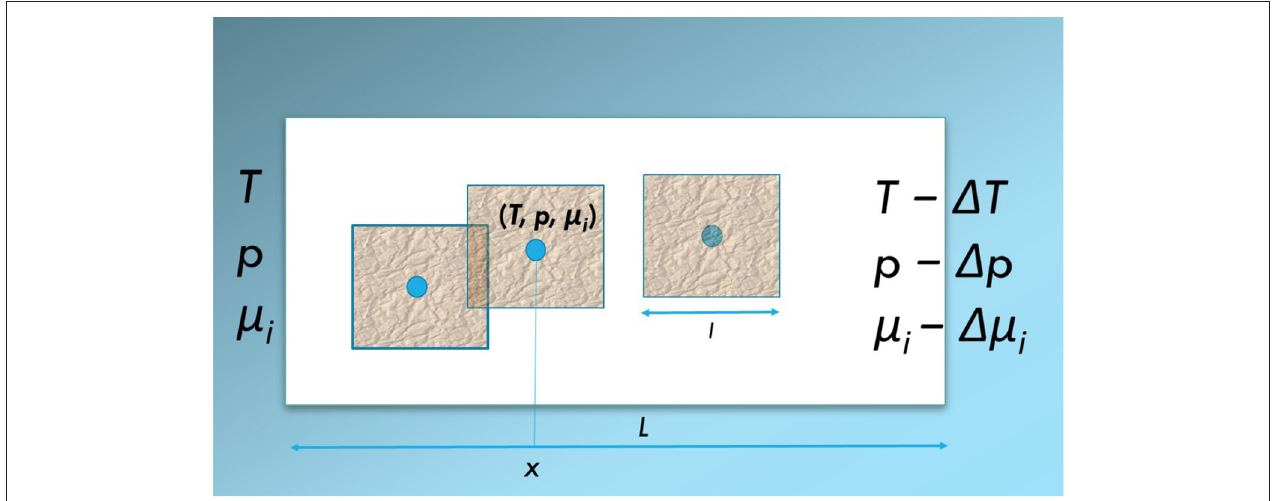
FIGURE 1 | Schematic illustration of a heterogeneous system (white box, length L ) exposed to a difference in temperature, 1 T , pressure, 1 p , or chemical potential 1µ i . The system is isolated in the y , z − directions. Net flows take place in the x − direction. Three representative elementary volumes, REVs (magenta squares, length l ) are indicated. The REVs may overlap. Each is represented by a set of variables ( p , T , µ i ) which defines a state (blue dot). Such states can be defined anywhere on the x -axis.